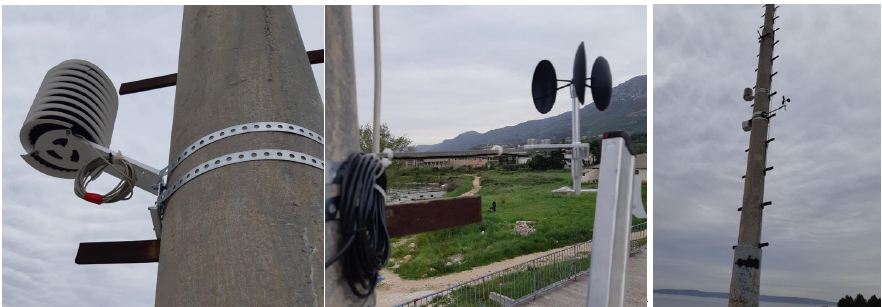
Figure 7. Installation of MeteoHelix and MeteoWind IoT Pro devices.